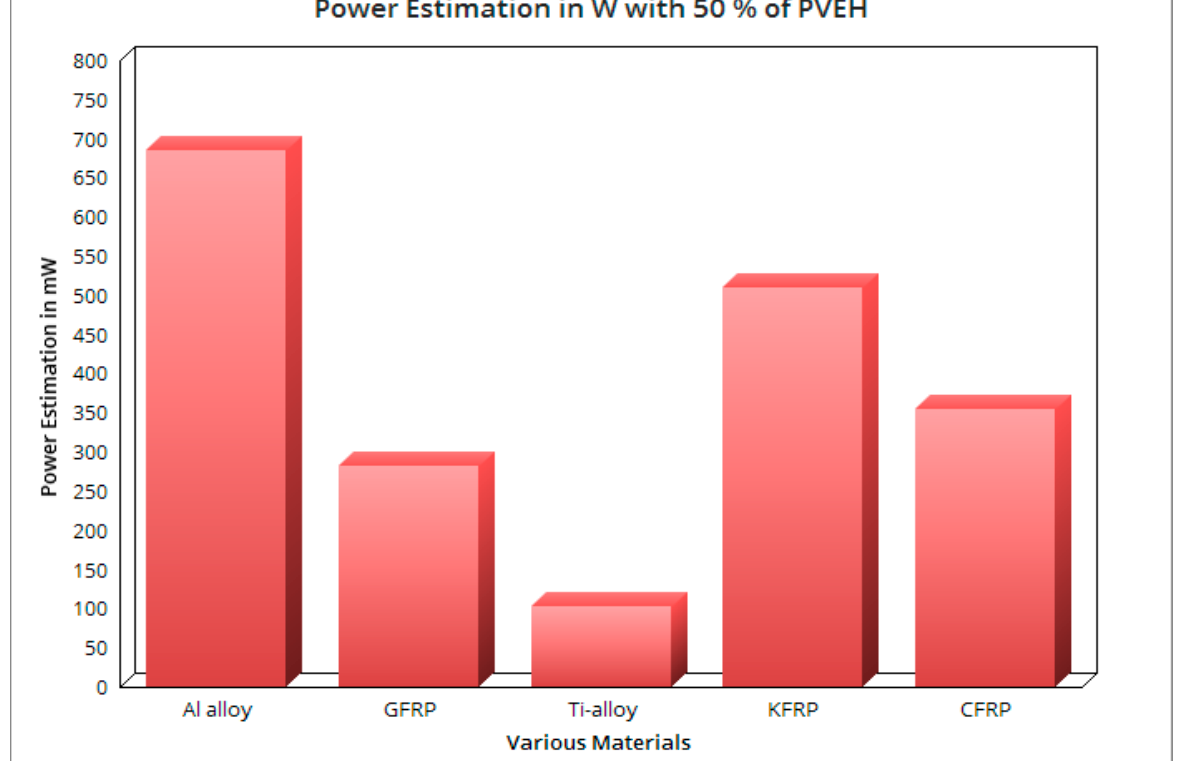
Figure 41. Power (P 0 ) in W with 75% attachment coverage-UAV wing.